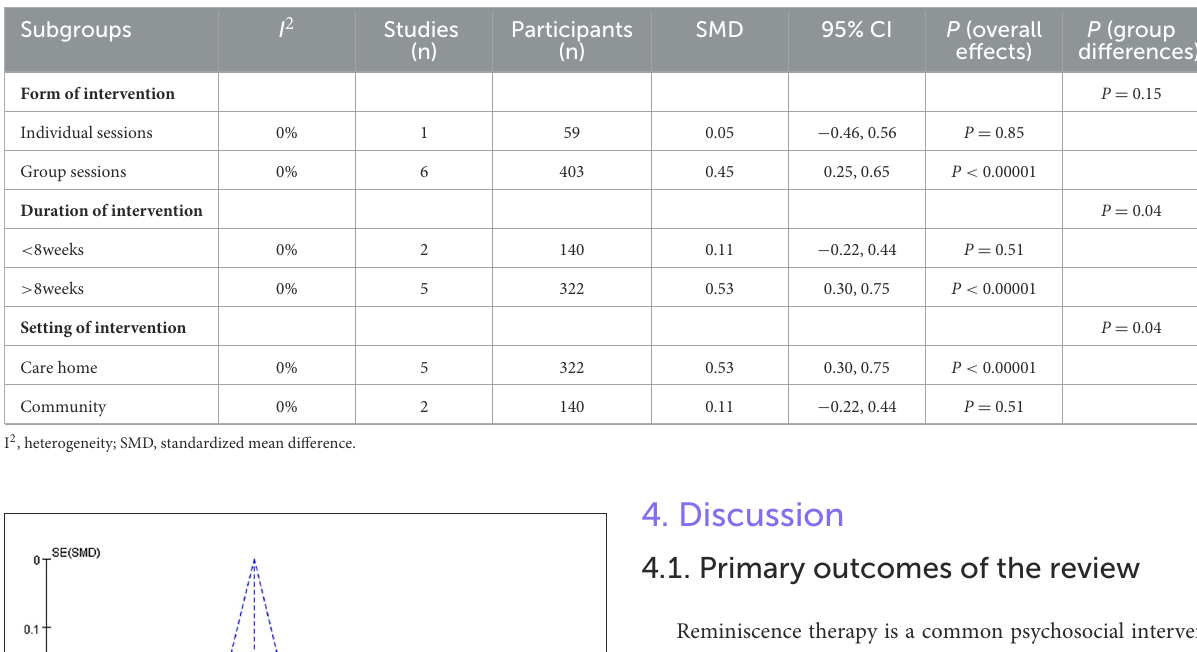
TABLE 3 Results of subgroup analysis of life satisfaction.